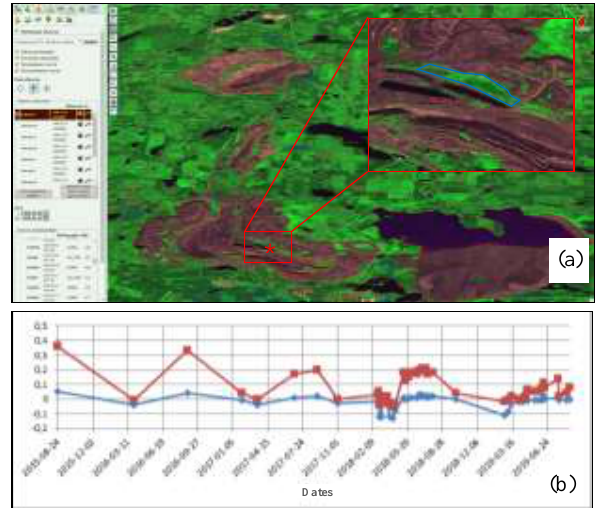
Figure 6. TWDS impact area (a) and multiyear profile (b) of monitored data for given control plot (marked by * sign on (a) panel). Red – NDVI, blue –